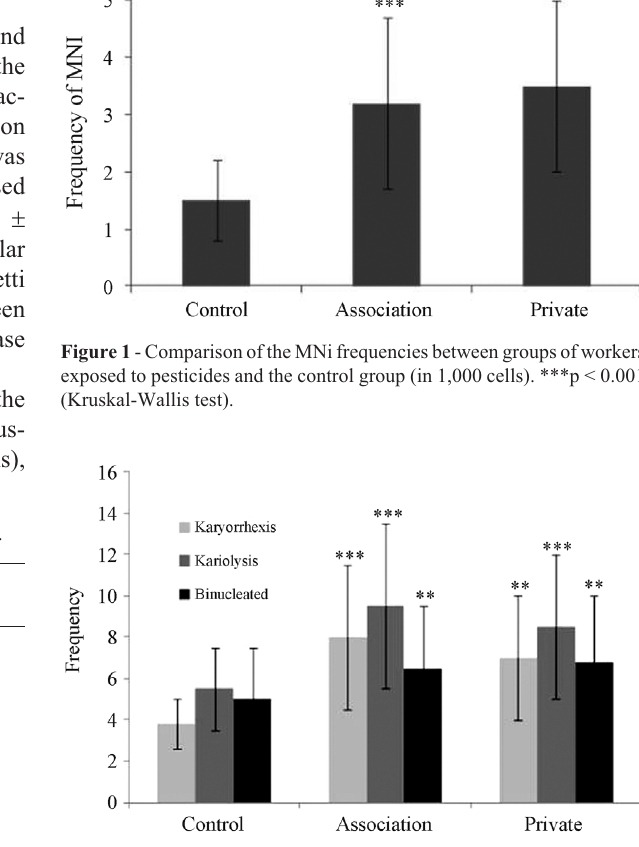
Figure 2 - Comparison between nuclear abnormality frequencies in groups of workers exposed to pesticides and the control group (in 1,000 cells). **p < 0.01; ***p < 0.001 (Kruskal-Wallis test).